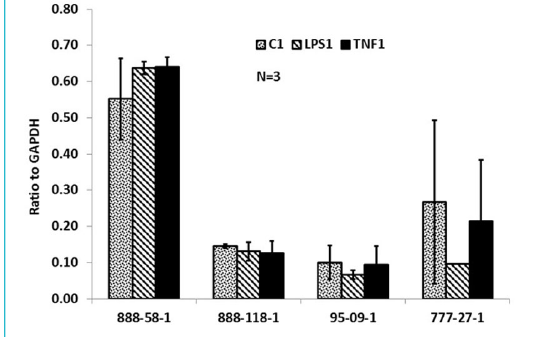
cell lines generated from blood samples from paediatric inflamma- tory bowel disease patients with genetic variations in genes inter- leukin-10 (IL-10), IL-10 receptor B (IL-10RB) and HO-1. For C1of 777-27, n = 2.Genotype of IL10 rs1800872 (G/T, Mut T) was GG for 888-58-1, GT for 888-118-1, GT 95-09-1, and GG for 777-27-1. Genotype of IL10 rs3024496 (A/G, Mut G) was AA for 888-58-1, AA for 888-118-1, GG 95-09-1, and AG for 777-27-1. Genotype of IL10RB rs2834167 (A/G, Mut G) was AA for 888-58-1, AG for 888-118-1, GG 95-09-1, and AG for 777-27-1. Genotype of HO-1 rs2071746 (A/T, Mut T) was AT for 888-58-1, AT for 888-118-1, AT 95-09-1, and AA for 777-27-1.Bar graphs show gene expression as a ratio to glyceraldehyde 3-phosphate dehydrogenase (GAPDH) in four B cell lines (888-58-1, 888-118-1, 95-09-1, and 777-27-1). Cells treated with TNFα, LPS, and control (without treatment) were indicated within the figure as TNF1, LPS1, and C1, respectively. All experiments were repeated three times.